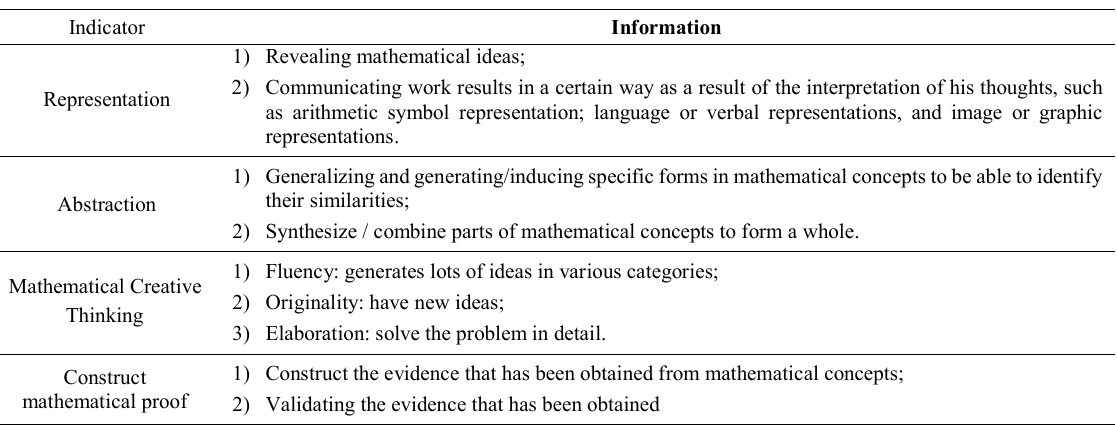
Table 1. Mathematical